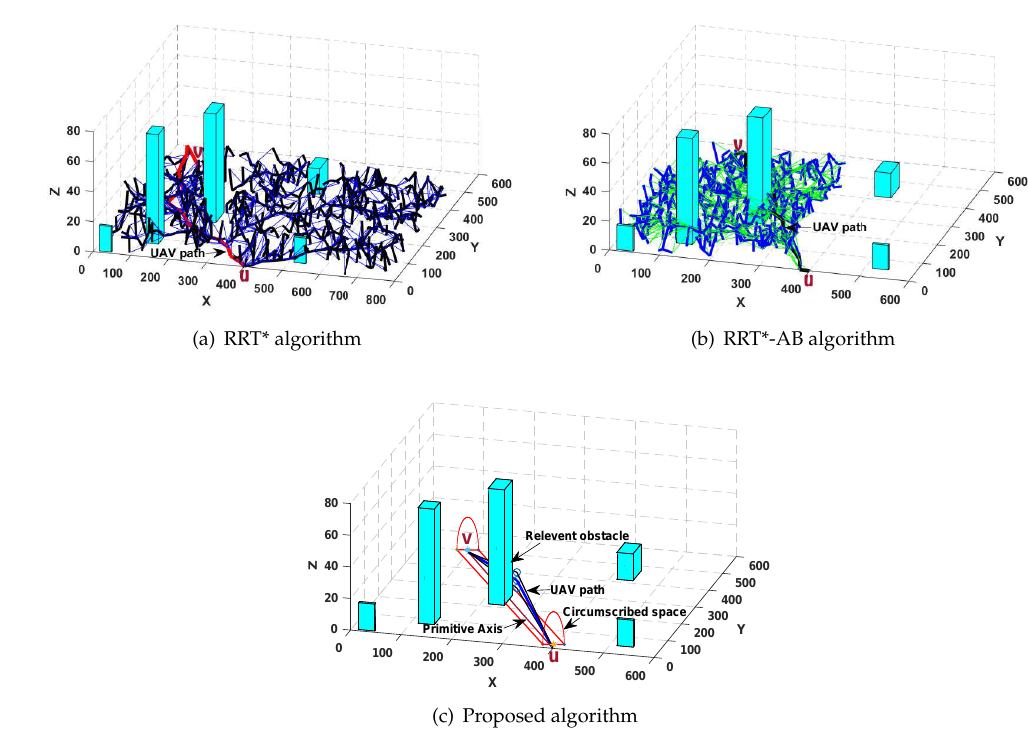
Figure 12. Pictorial overview of the proposed, RRT* and RRT*-AB algorithms paths.